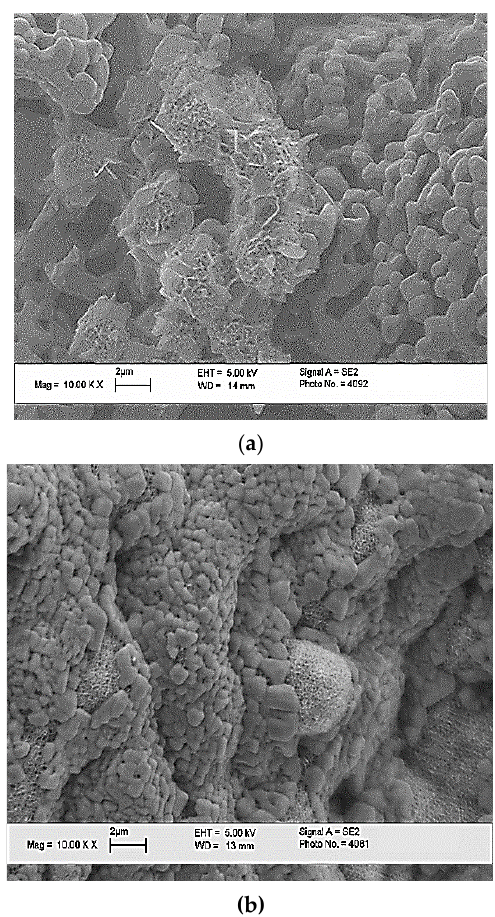
Figure 13. The SEM images of the surface of the ceramic sample with weight ratio of Ca(PO 3 ) 2 /Ca 2 P 2 O 7 = 0/100 after mineralization for 1 day ( a ), and for 7 days ( b ) of the model medium SBF.